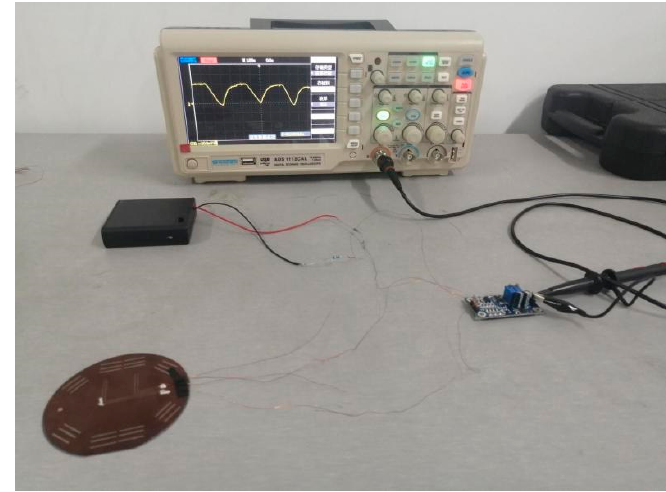
Figure 13. The measurement system of the flexible thermocouple film sensor.